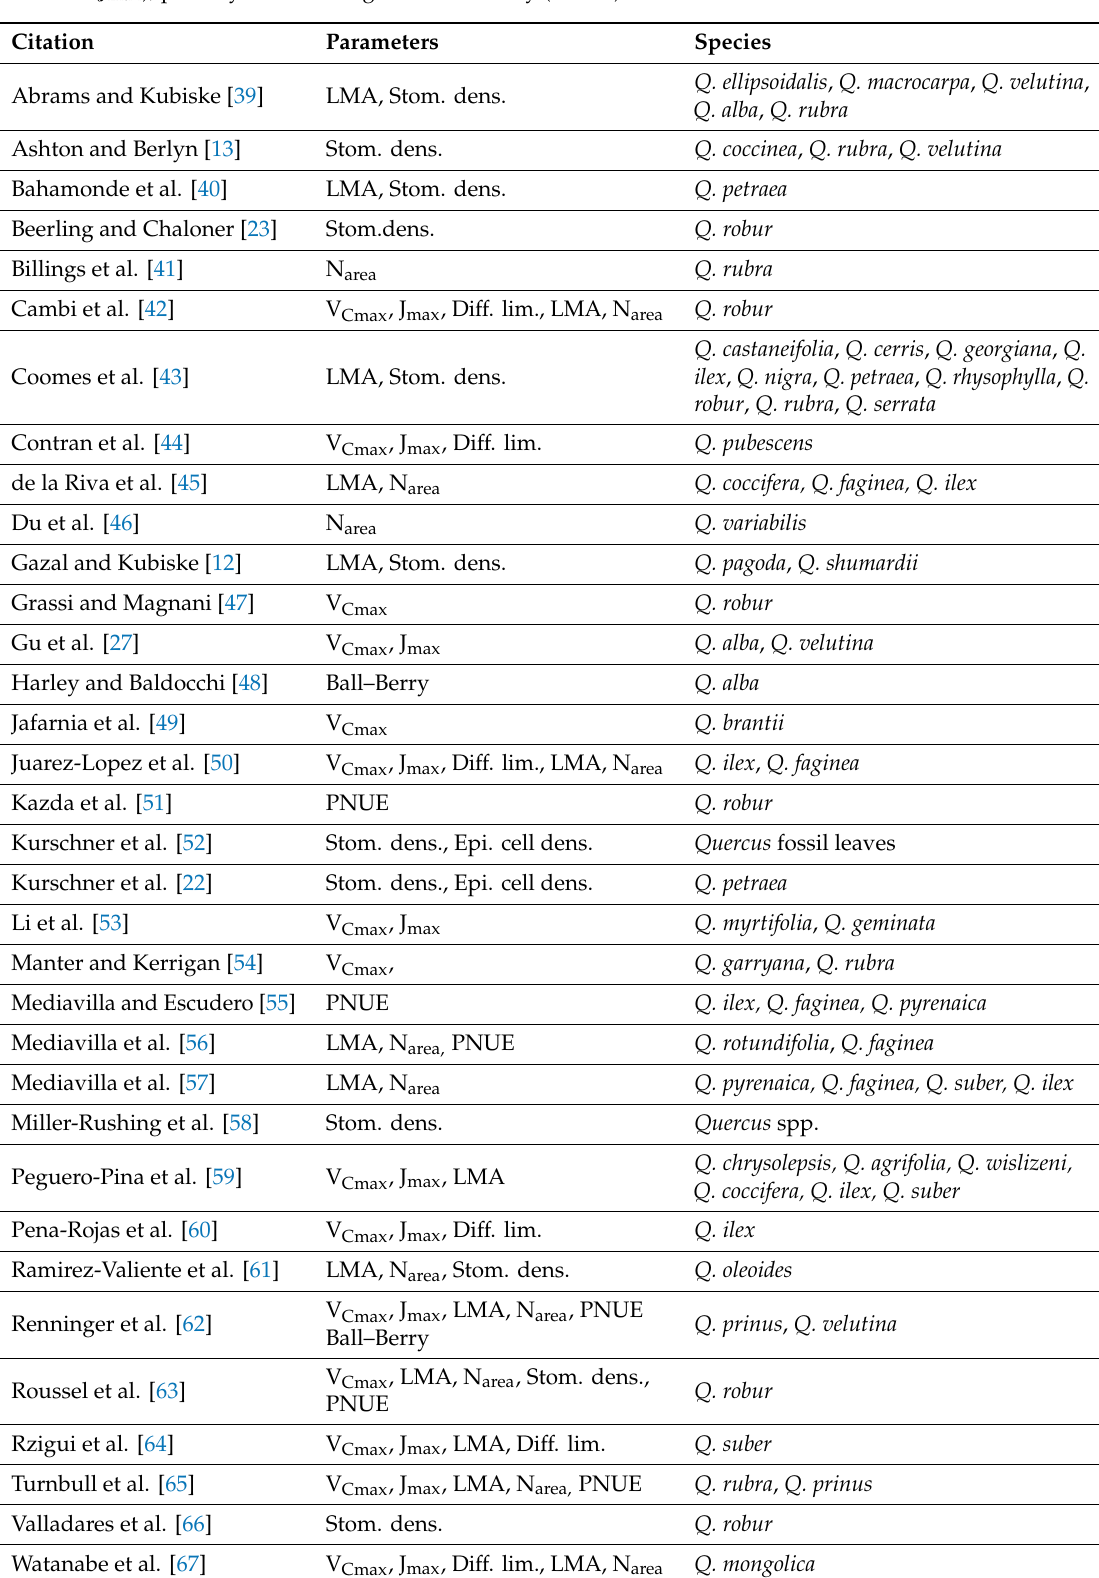
Table 1. Publications used for oak literature survey of physiological parameters (Figure 6). leaf